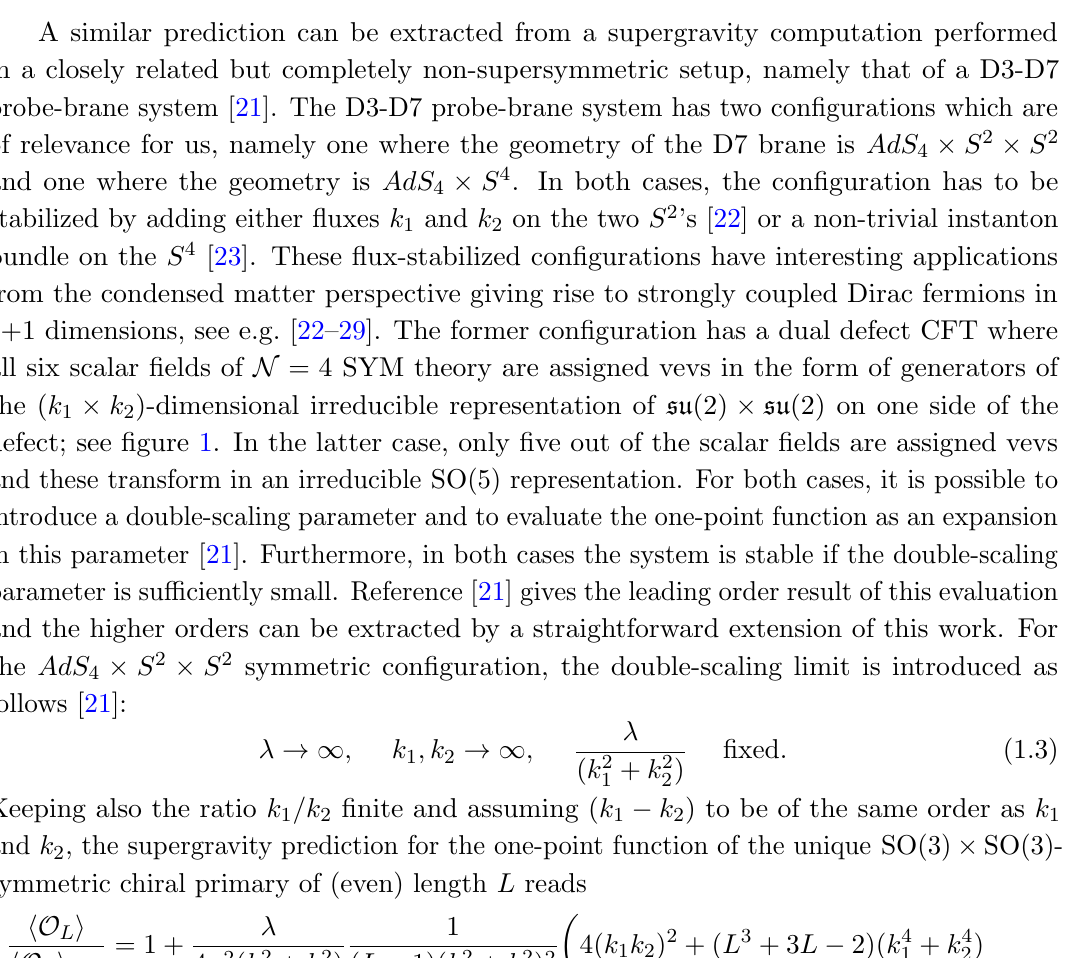
Figure 1 . Brane con(cid:12)guration in string theory (left) and the dual (cid:12)eld-theory picture (right) with di(cid:11)erent gauge groups on each side of the defect at x 3 =